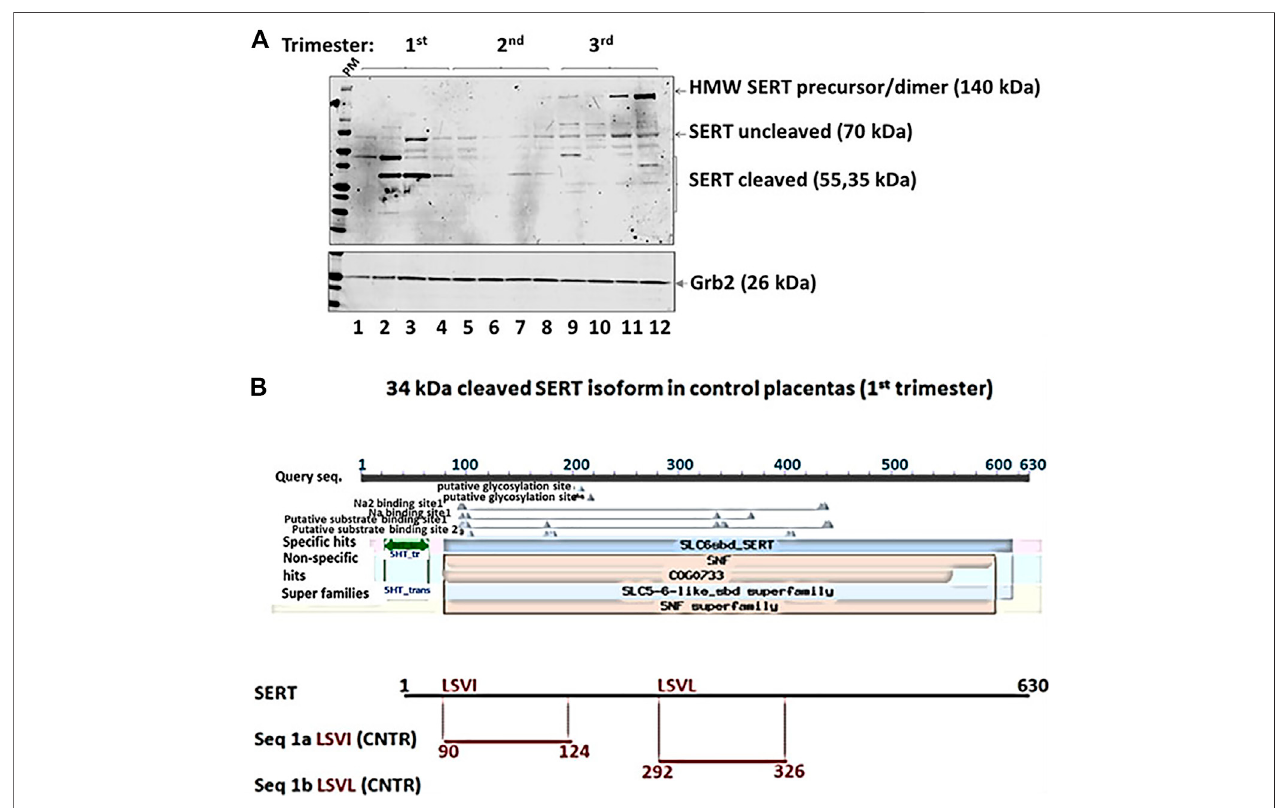
FIGURE 5 | Edman degradation was performed to obtain the N-terminal sequence of truncated SERT protein versions. Two potential N-terminal SERT fragments were present in the sample (A) . The sequences were compared with two 5HT transporter isoforms downloaded from Unipro (B) . The sequence alignment was performed using ClustalW2 on two isoforms of SERT and potential N-terminal fragments on SLC6A4 (Synonyms: HTT, SERT; Organism Homo sapiens (Human), Taxonomic identi fi er9606 [NCBI]).